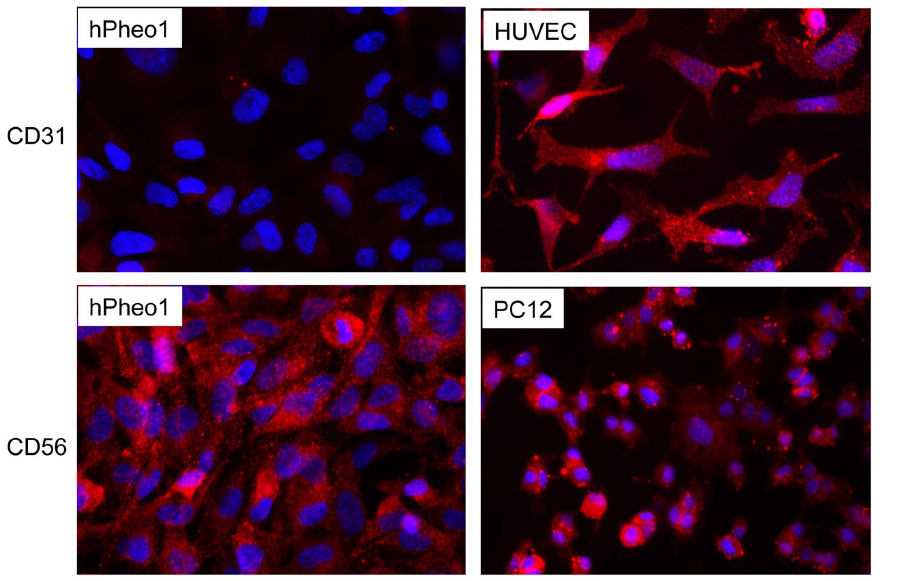
Figure 3. Immunofluorescence reveals CD56 is positive in hPheo1 and PC-12 cells. CD31 is negative in hPheo1 but positive in HUVEC cells.